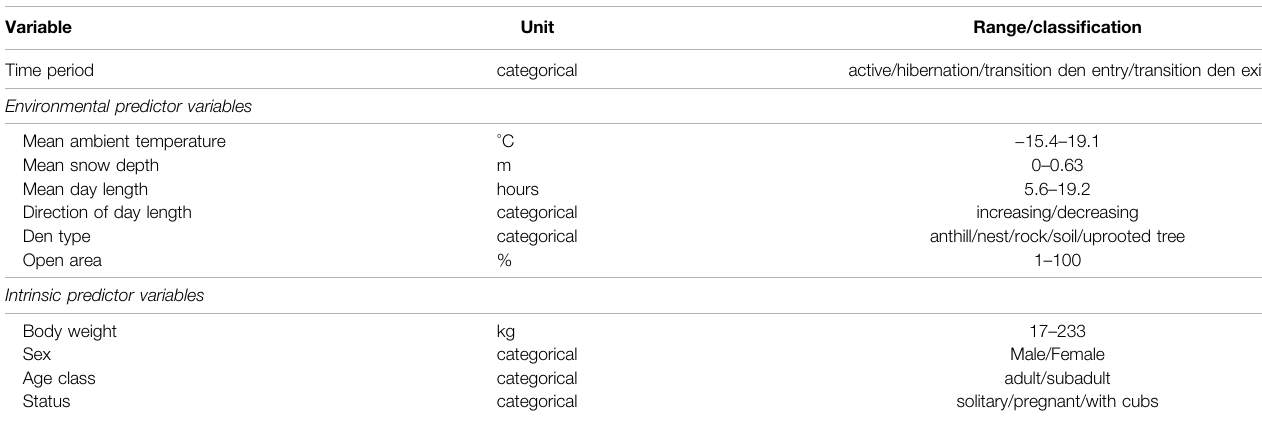
TABLE 1 | Explanation of dependent and independent variables, which were available for inclusion in the statistical analysis.